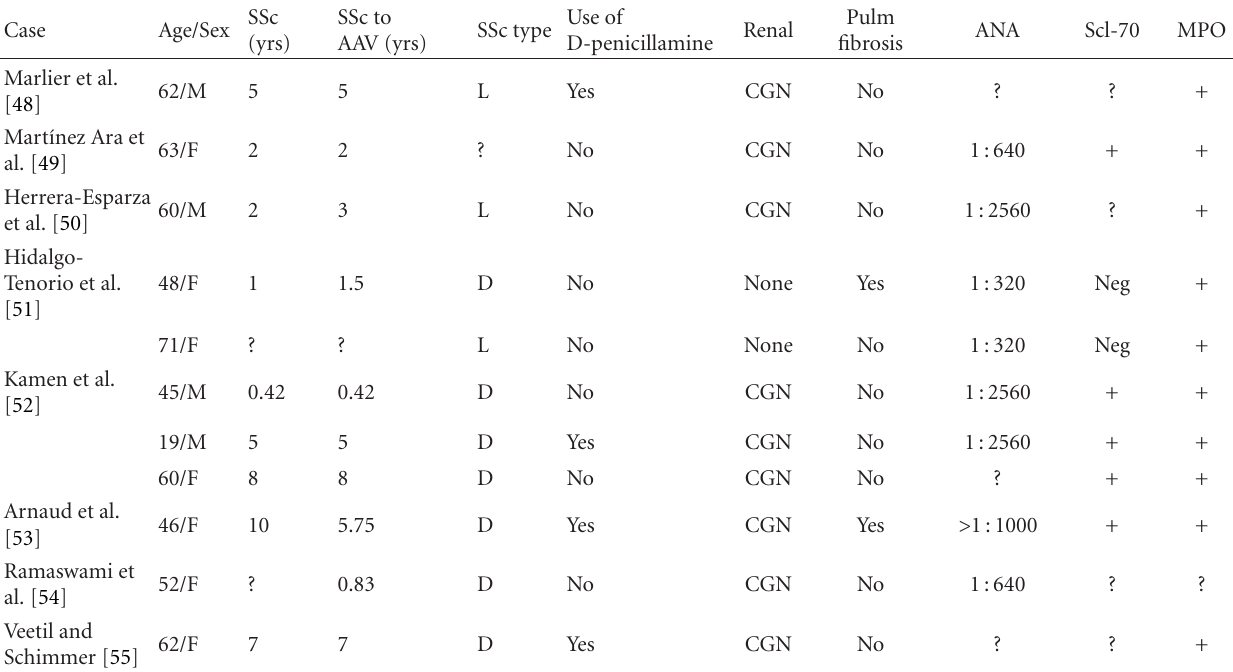
Table 3: Eleven new cases of ANCA-associated vasculitis in SSc.